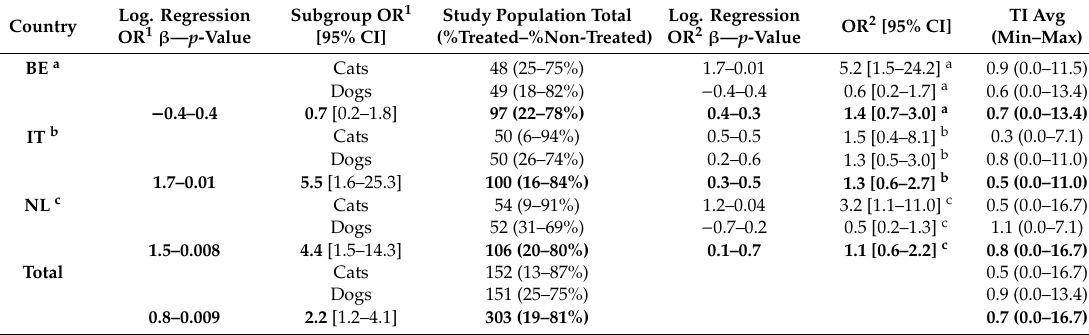
Table 1. Antimicrobial usage in companion animals expressed as the sum of treatment incidence (TI) at animal